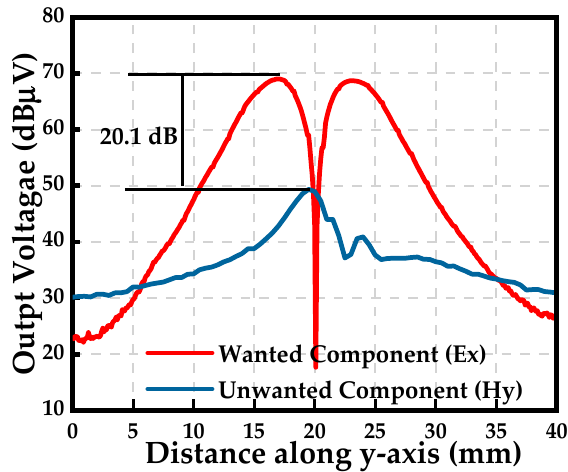
Figure 16. Measured H-field rejection at 1.575 GHz.